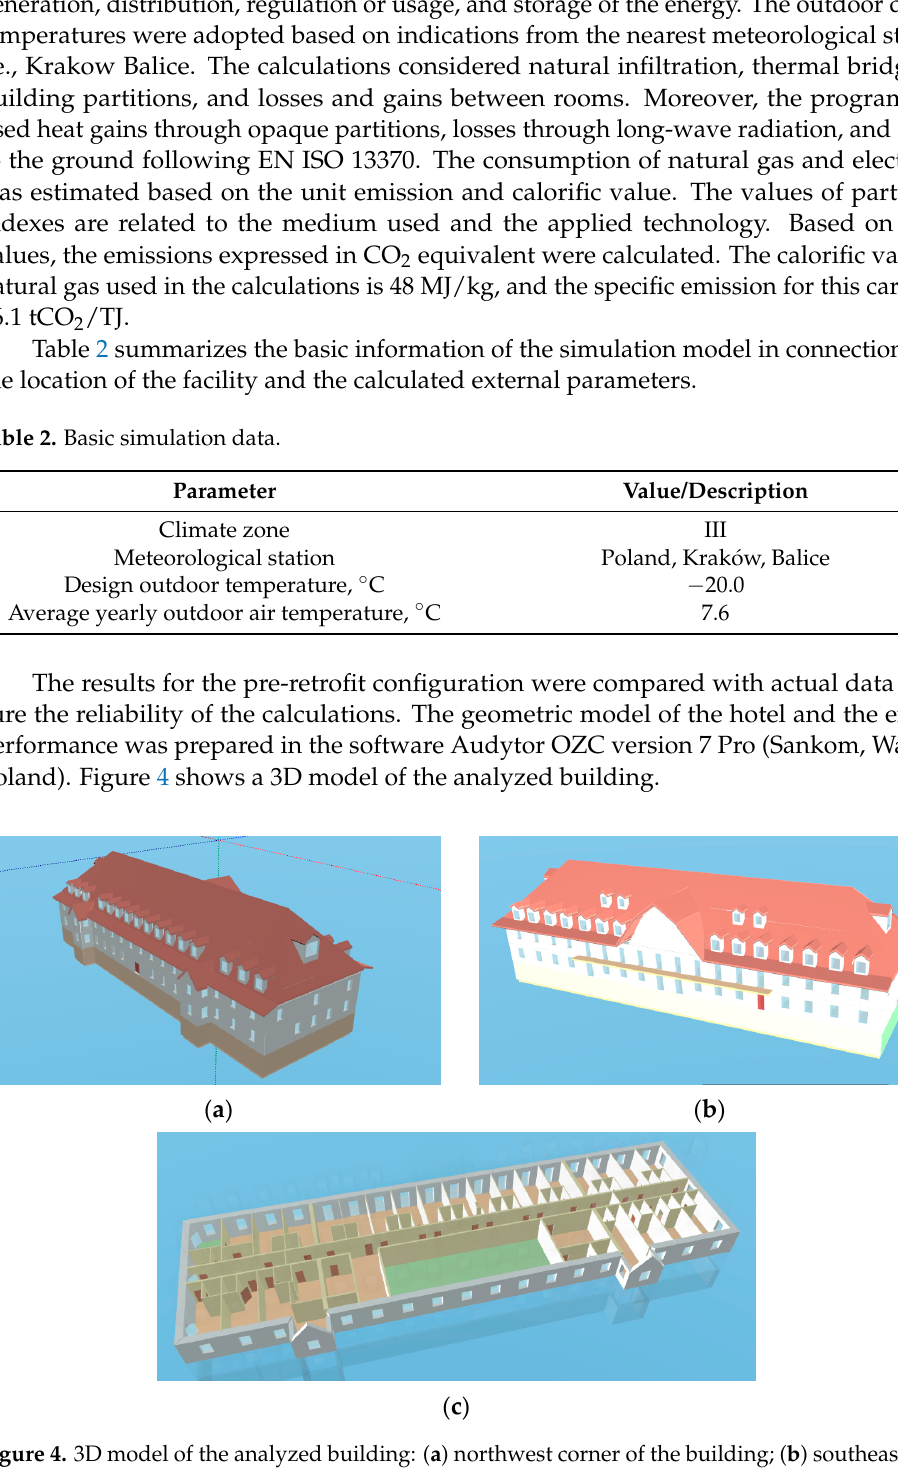
Table 3. Table 3. Thermal characteristics of the building envelope. Building Envelope